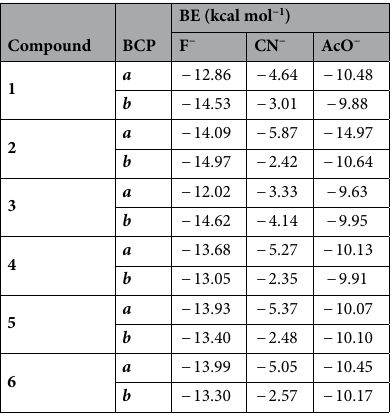
Table 10. Binding energies (BE) calculate through the equation presented by Espinosa (BE = V(r)/2) for compounds 1 – 6 interactins with anions (F − , CN − , and AcO −